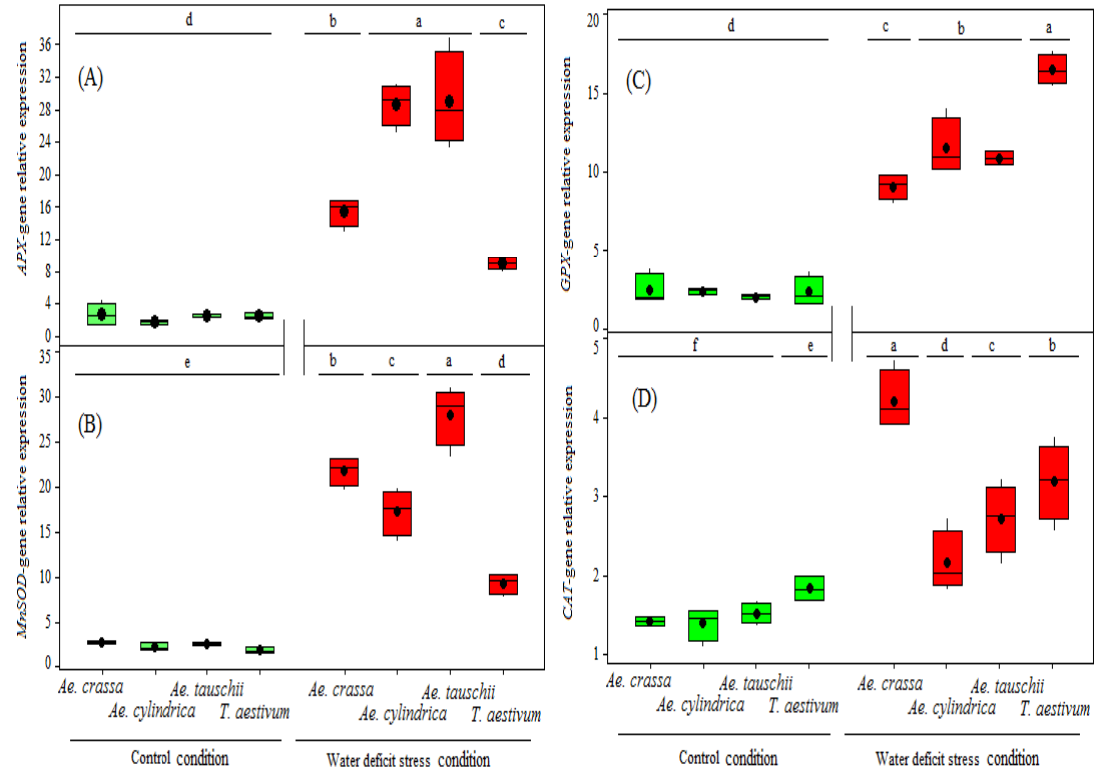
Figure 2. Box plots of the investigated accessions for the ( A ) APX , ( B ) MnSOD , ( C ) GPX , and ( D ) CAT gene relative expression in the control and water deficit stress conditions. Different letters on each box indicate significant di ff erence at p ≤ 0.01. Each dot box, horizontal bar within box, and box indicate significant difference at p ≤ 0.01. Each dot box, horizontal bar within box, and internal boxes and whisker indicate the mean, median, the first and third quartiles, and minimal/maximal values, respectively.